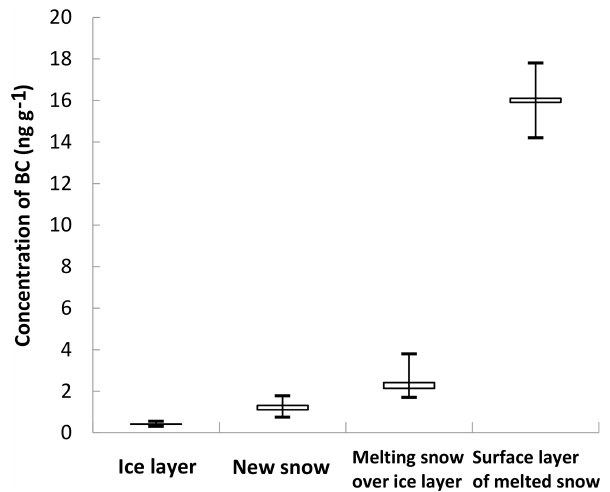
Figure 2. The BC concentrations in the melt–refreeze ice layer and melting snow, and its concentrations in the new snow and the sur- face layer of melting snow are also shown as a comparison. New- snow samples were only collected in Elson Lagoon and the Chukchi Sea during the measurement period. The box indicates the mean (upper) and median (bottom) values of the observations, and the whiskers constrain the full extent of the observations.